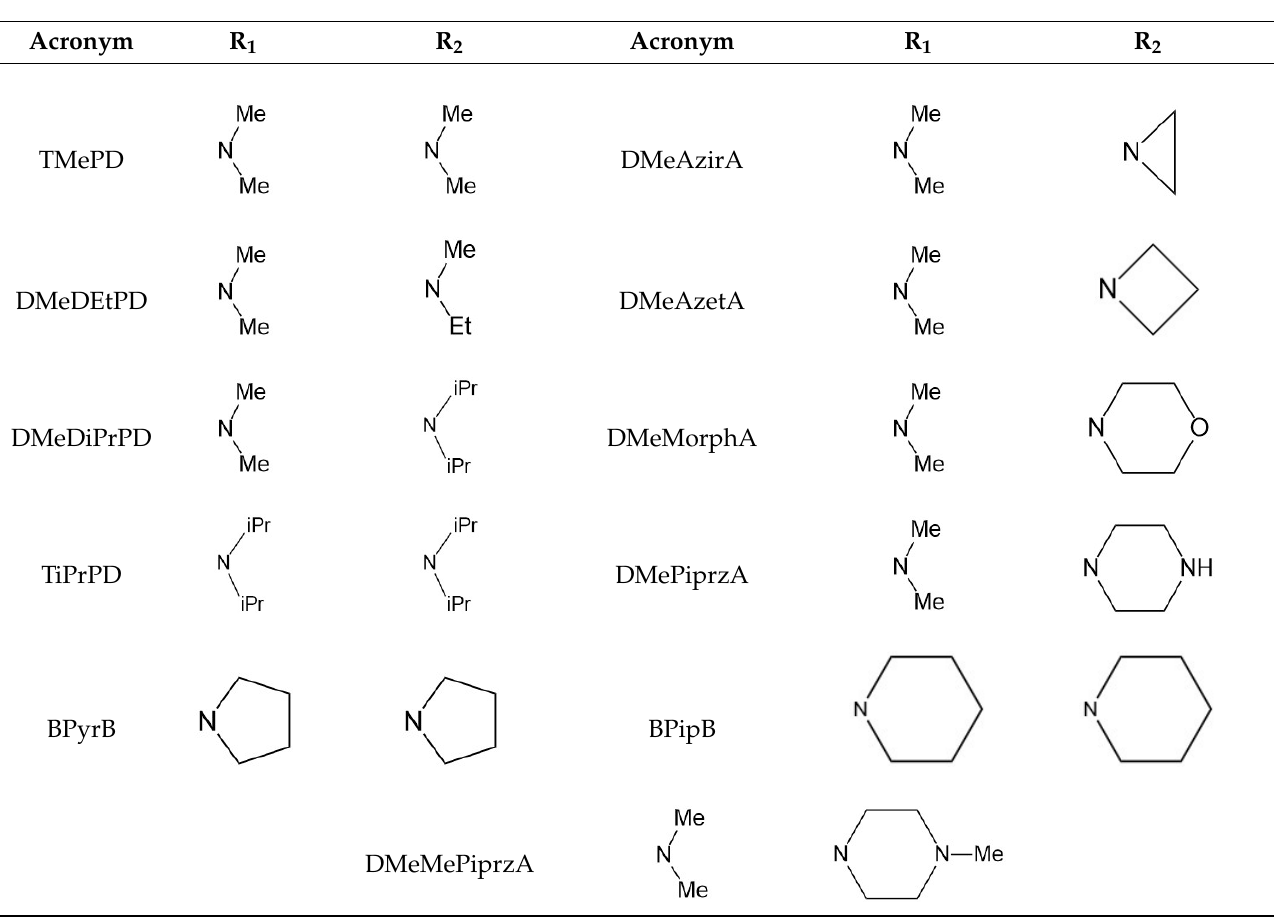
Figure 1. General structure of each N,N,N’,N’ -tetrasubstituted p -phenylenediamine with R 1 and R 2 defined in Table 1. Table 1. All side R-Groups of each N,N,N’,N’ -tetrasubstituted p -phenylenediamine